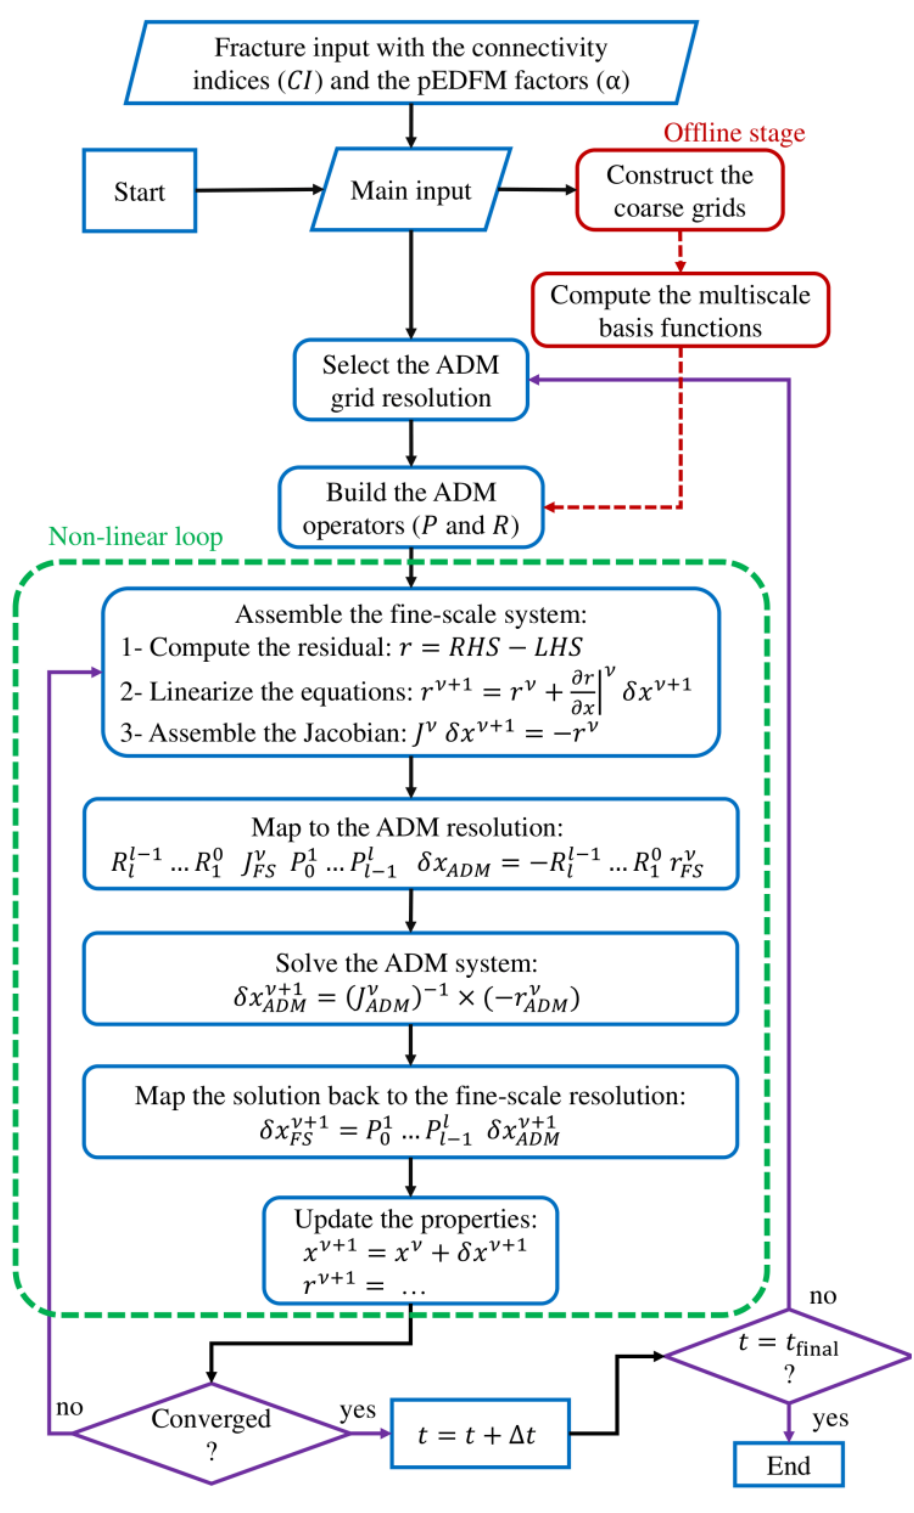
Figure 2. Workflow for the ADM strategy.